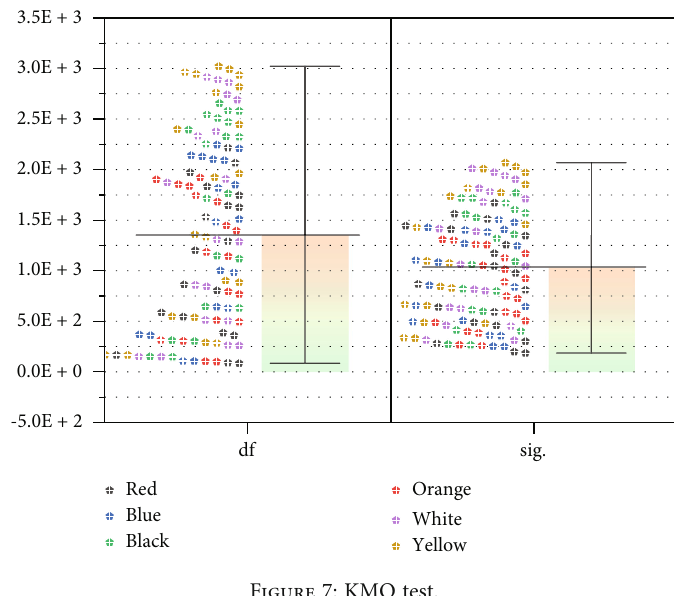
Figure 7: KMO test.